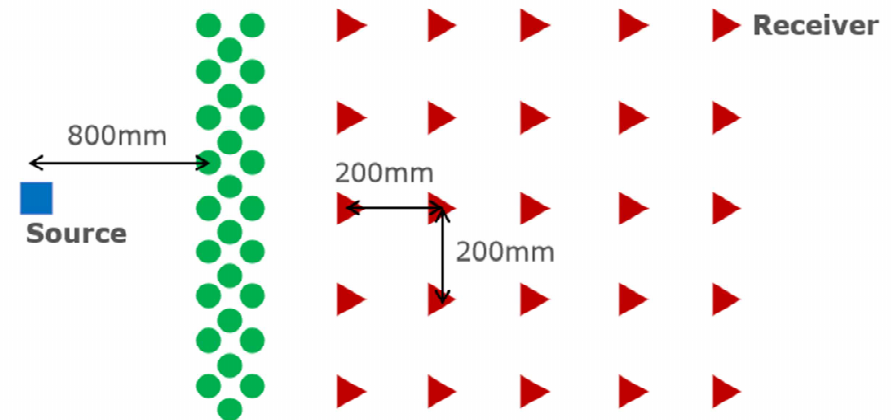
Figure 4. Schematic layout of the equipment location during the third set of measurements.